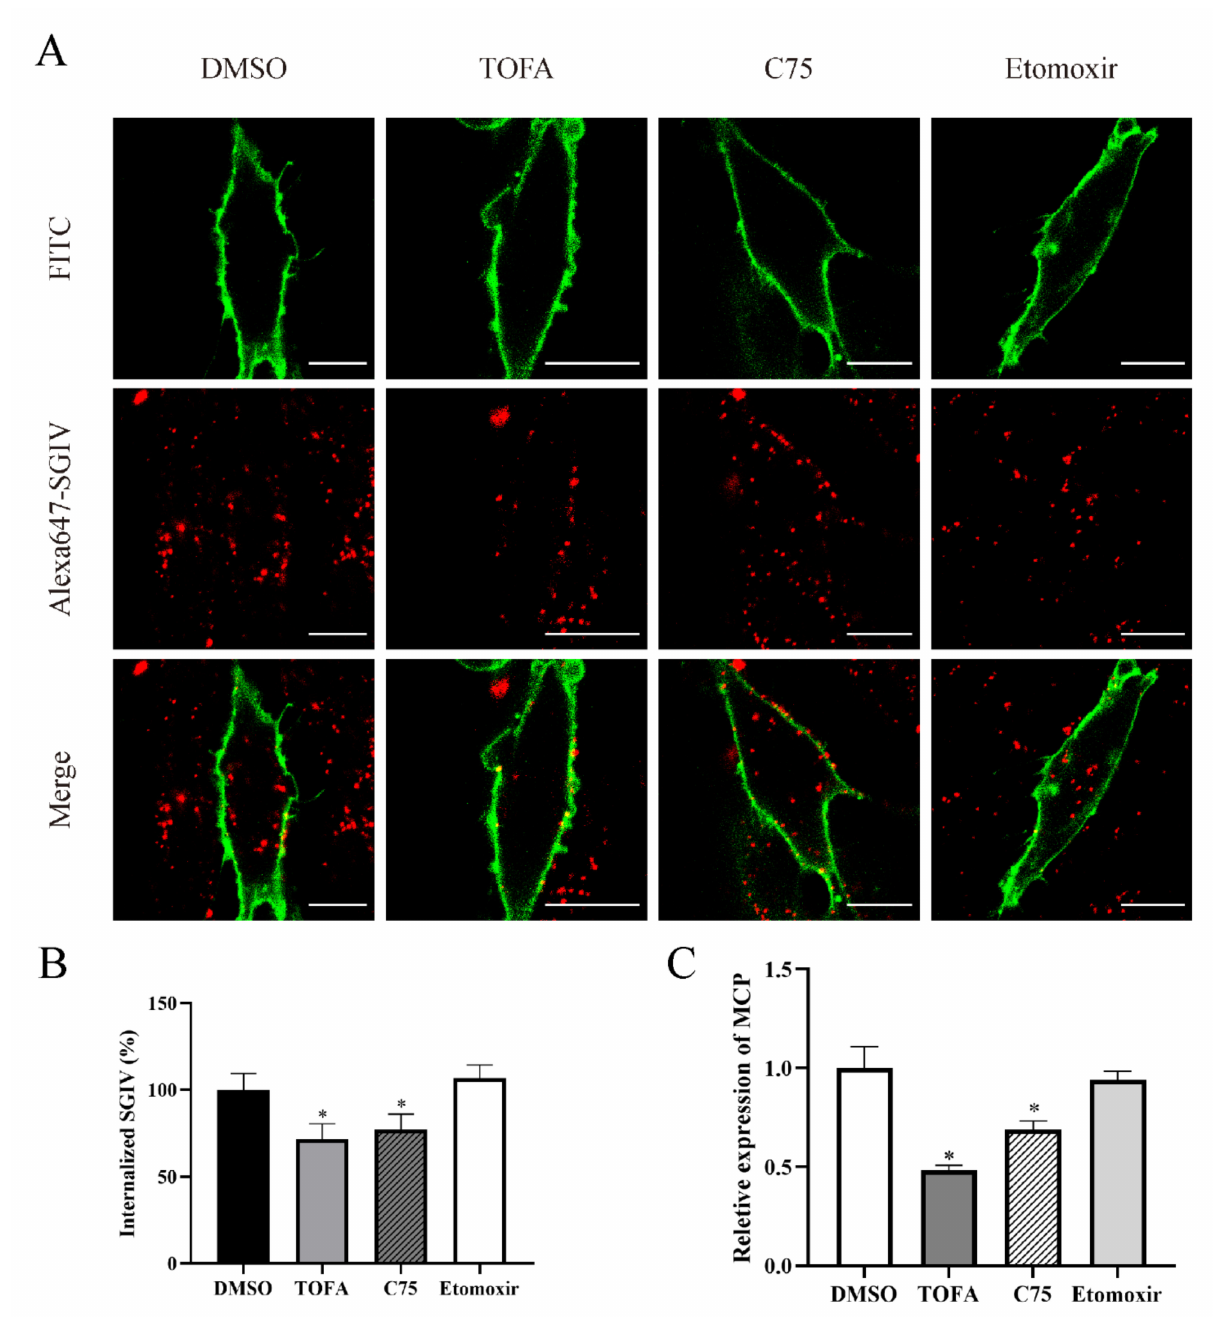
Figure 7. Fatty acid biosynthesis, but not β -oxidation, participates in the process of SGIV entry. TOFA and C75 inhibited SGIV entry, and the fixed cells were observed by CLSM ( A , B ). The mRNA relative expression of SGIV MCP was suppressed by TOFA and C75 intracellularly ( C ). n = 3, data are expressed as means ± SD. * indicates p <